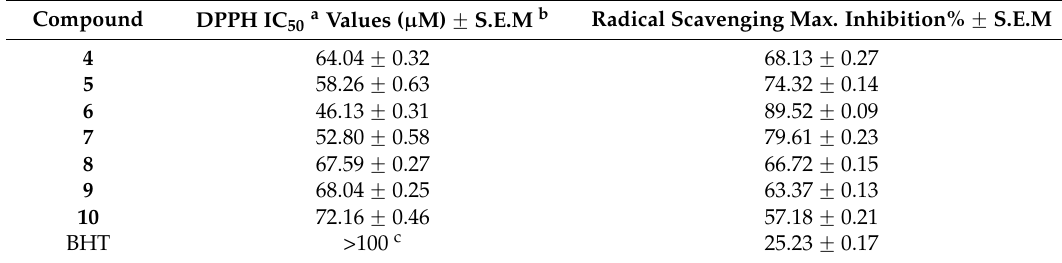
Table 3. IC 50 values and maximum inhibition of activity at 100 µ M of the DPPH radical scavenging and lipid peroxidation inhibition assays.